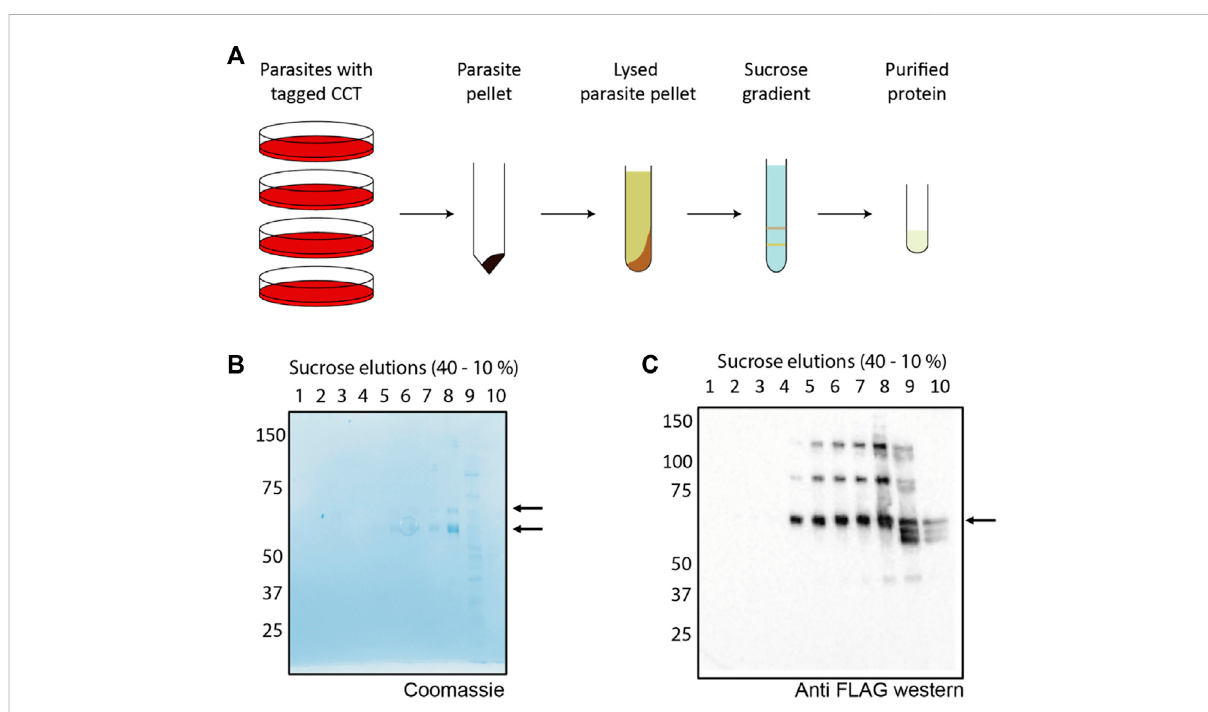
FIGURE 3 Puri fi cation scheme andanalysisofPfCCT (A) A general schematic for puri fi cation oftheCCT complexfrom P. falciparum .Parasitescontaining an endogenous tag for PfCCT puri fi cation were grown, isolated using saponin lysis and lysed by nitrogen cavitation. The parasite lysate was then incubatedwithanti-FLAGresinbeforeelutingtheboundfractionforapplicationtoa10% – 40%sucrosegradient. (B) ACoomassiestainedSDS-PAGE gel shows the elution peak from the anti-FLAG resin contains the tagged CCT8 subunit (top arrow, ~65 kDa) and the “ CCT box ” containing the rest of the seven subunits (~60 kDa, bottom arrow). (C) The elution peak is applied to a 10% – 40% sucrose gradient (Lewis et al., 1992). Gradient